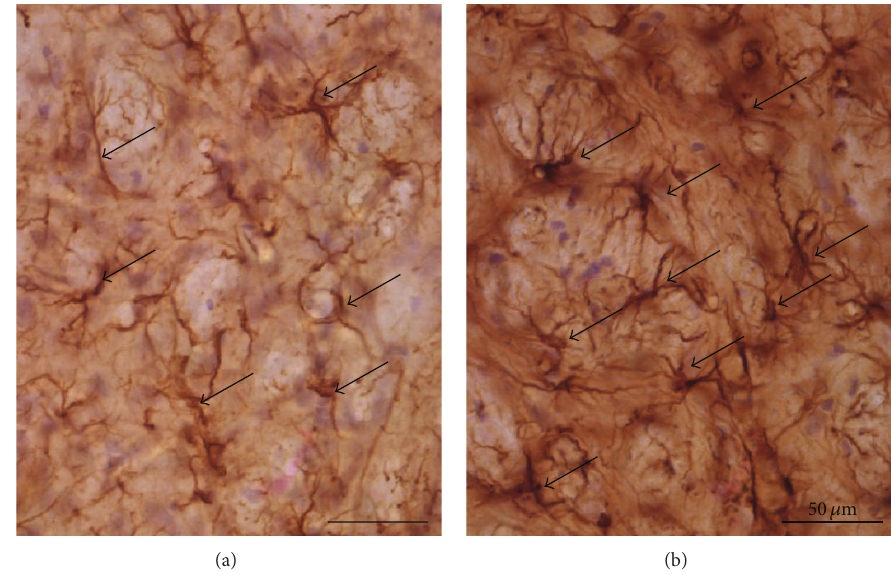
Figure 1: Astrocytes activated in a rat model of Parkinson’s disease. Astrocytes (arrows) in the globus pallidus of rats after unilateral striatalle- sion of dopaminergic neurons by injection of 6-hydroxydopamine (6-OHDA). (a) Contralateral hemisphere; astrocytes have short cellular processes. (b) Ipsilateral hemisphere; astrocytes are in an activated state characterised by long cellular processes and enlarged cell bodies with an intense staining. Staining of glial fibrillary acidic protein (GFAP). For detailed information, see